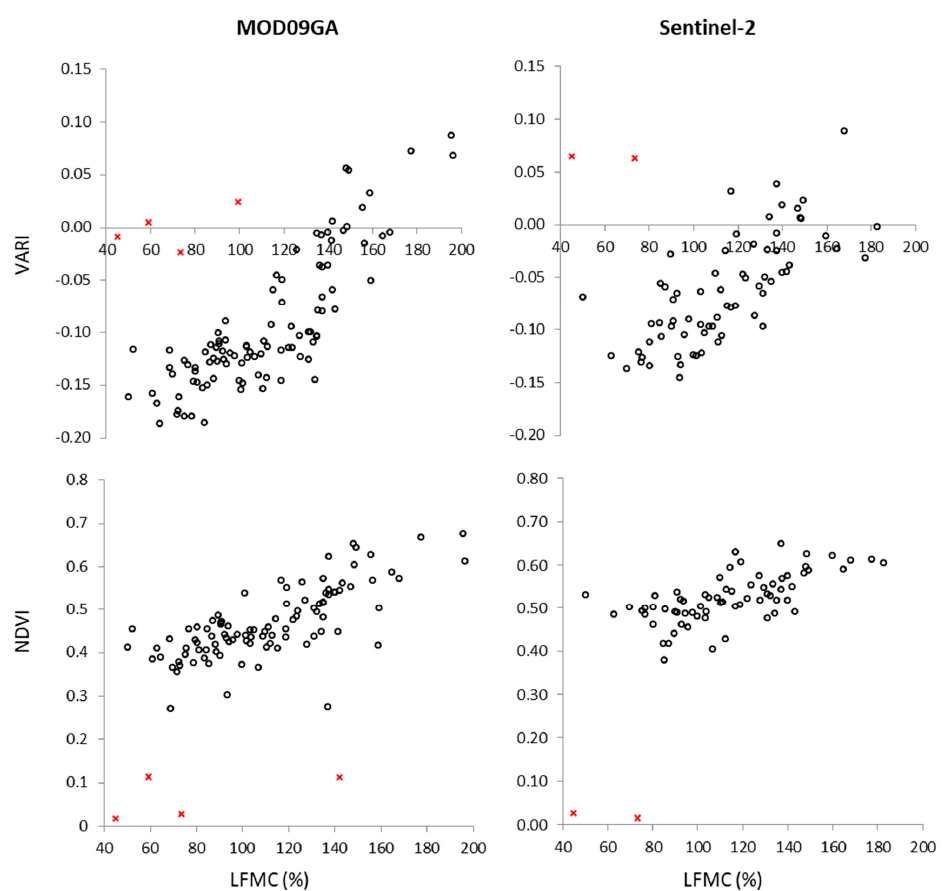
Figure A1. Examples of scatter plots of NDVI and VARI derived from MOD09GA and Sentinel-2. Ouliers detected and excluded from the modelling datasets are depicted as red crosses.